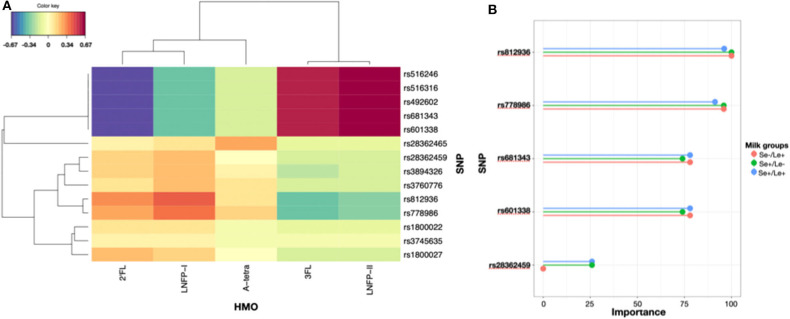
(A) sPLS-selected genetic polymorphisms and their associations with HMO levels expressed as a distance between genotypes and HMO levels in 142 individuals. (B) Importance of genetic polymorphisms in predicting the milk group of mothers with a MultiLayer Perceptron model.